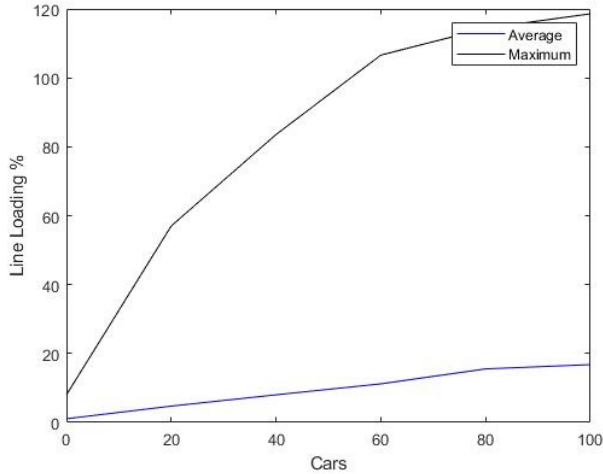
Figure 10. Maximum single cable loading (percentage) observed across the network over varying EV penetration vs. average cable loading plotted against EV penetration.